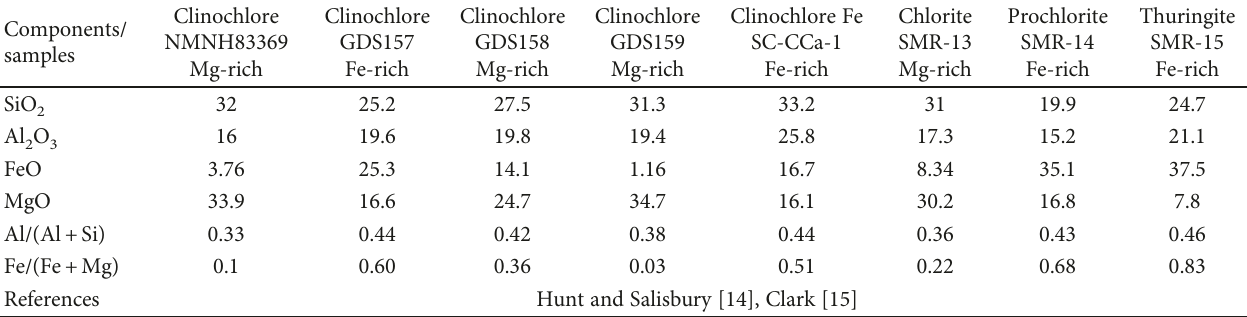
Table 1: Description and mineral components of chlorite samples collected from the USGS spectral library in this study. Components/ samples